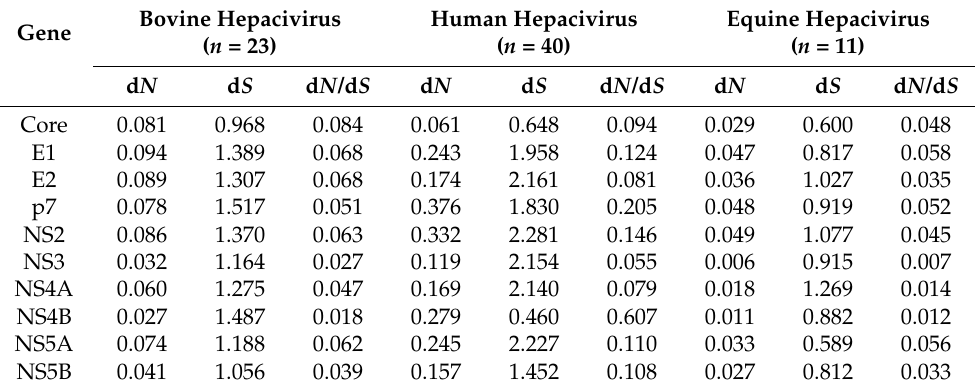
Table 3. Comparison of the mean numbers of nonsynonymous (d N ) and synonymous (d S ) substitu- tions per site, and their ratios, in the coding regions of hepacivirus in bovine, humans, and